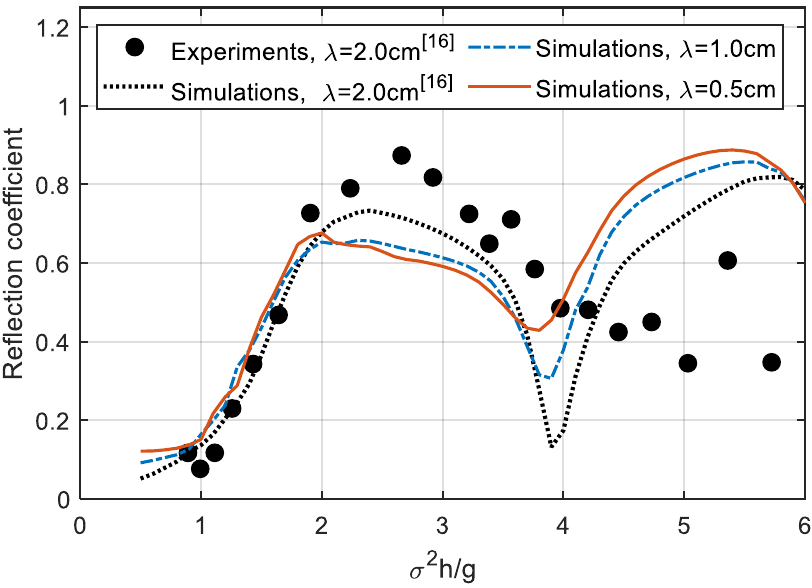
Figure 6. Comparison of the reflection coefficient for the platform with various fishnet mesh sizes.